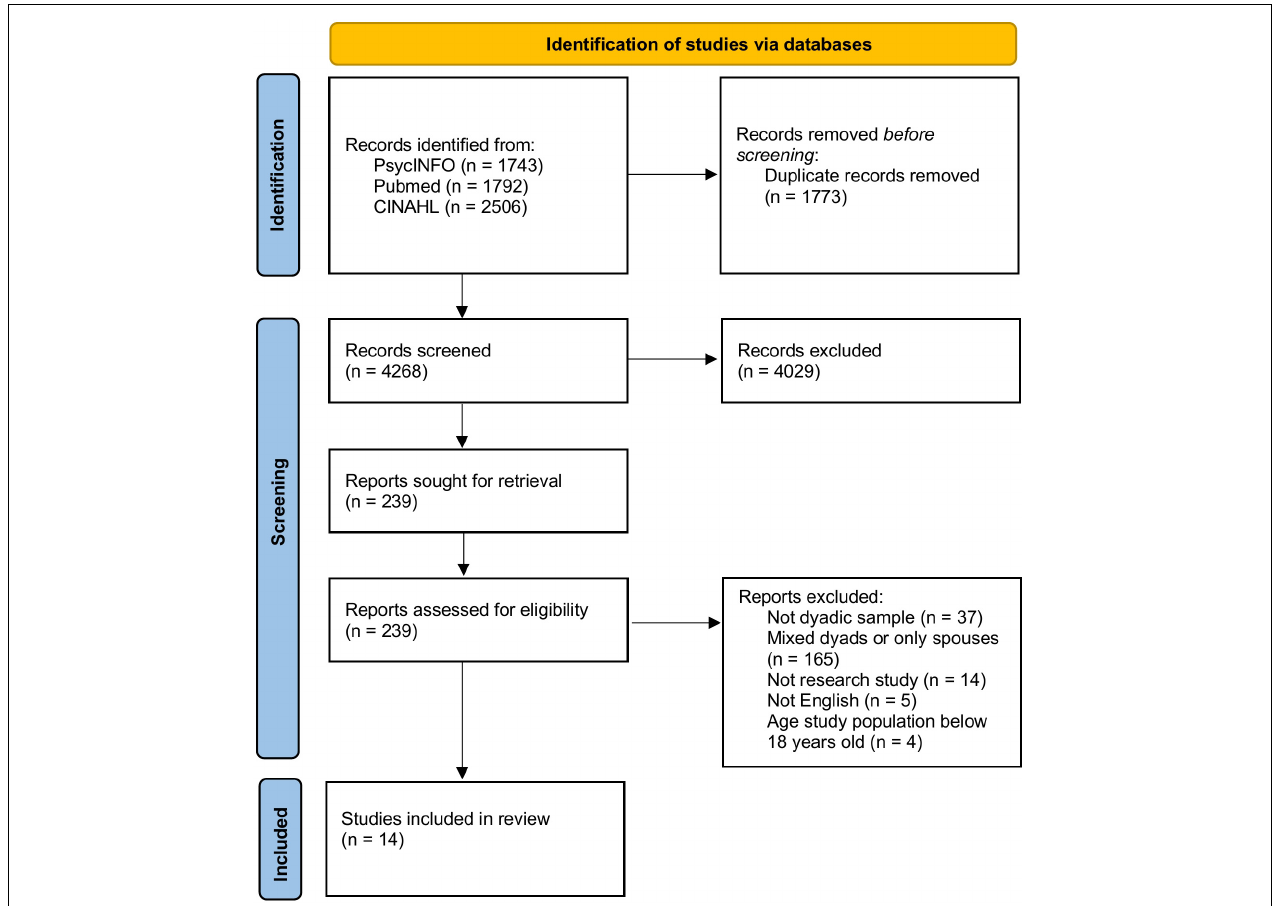
FIGURE 1 | PRISMA (Preferred Reporting Items for Systematic Reviews and Meta-Analyses) flow diagram of study selection process.